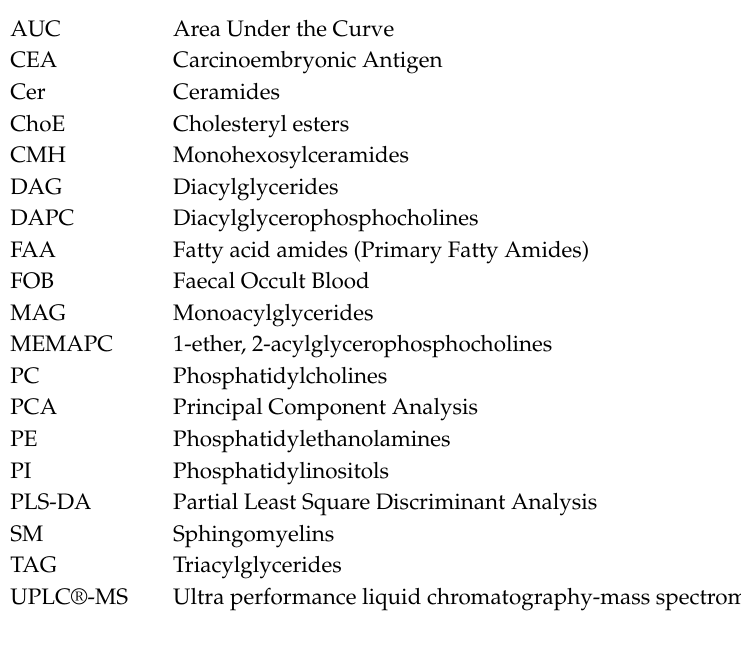
Figure S2, Multivariate analysis of paired group. (A) CRC vs. AD: R2X = 0.29 and Q2 = 0.24 t[2]: R2X = 0.19 and Q2 = 0.22). Black CRC, grey AD. (B) CRC vs. control: R2X = 0.30 and Q2 = 0.25, t[2]: R2X = 0.19 and Q2 = 0.24). Black CRC, white healthy. (C) AD vs. control: R2X = 0.28 and Q2 = 0.24, t[2]: R2X = 0.15 and Q2 = 0.15. Grey AD, white healthy. Supplementary Figure S3, Boxplot representation of the clinical parameters distribution on the distinct groups of samples (C, AD and CRC). Supplementary Figure S4, Mapping of altered genes and metabolites into the three metabolic pathways identified: sphingolipid metabolism (A), glycerophospholipid metabolism (B) and glycosylphosphatidylinositol (GPI)-anchor biosynthesis (C). Genes detected are coloured in a range green-red, depending on the Fold Change and metabolites in a range blue-yellow. Supplementary Table S1, List of the 105 metabolites analysed in the study. Supplementary Table S2, Metabolites differentially expressed between control, AD and CRC groups (ANOVA test). Supplementary Table S3, Clinical correlations between metabolites included Number of missing values obtained for each